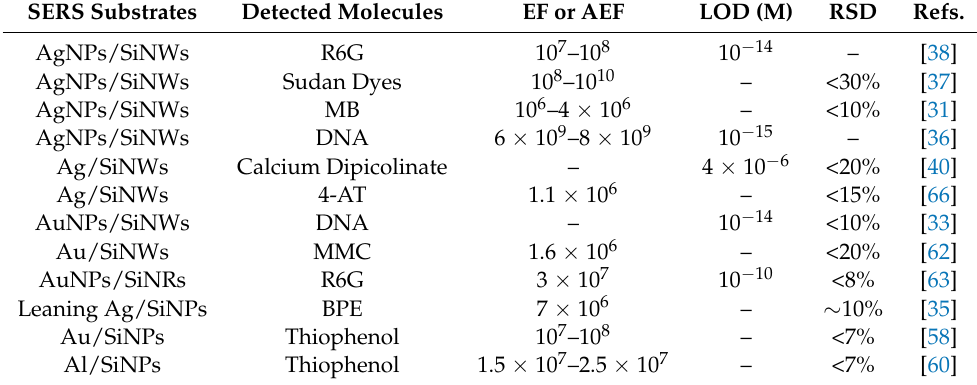
Figure 2. ( a ) Si nanowires produced by the vapor–liquid–solid growth (height: 5 µ m < h < 6 µ m and nanowire diameter: 50 nm < D < 150 nm) coated with Ag nanoparticles (diameter: 4 nm < d < 40 nm); ( b ) SERS spectrum of Rhodamine 6G (R6G) molecules (C R 6 G = 10 − 9 M) adsorbed on AgNPs/SiNWs. ( a , b ) are reprinted with permission from [38], copyright 2009 American Chemical Society; ( c ) Si nanorod array obtained with the combination of the NSL and MACE techniques followed by the grafting of gold nanoparticles having a diameter of 20 nm on Si nanorods (period P ∼ 500 nm between two Si nanorods, diameter D ∼ 200 nm and height h ∼ 1300 nm); ( d ) SERS spectra of R6G molecules adsorbed on AuNPs/SiNRs for concentrations varying from 10 − 10 to 10 − 6 M; ( c , d ) are reprinted with permission from [63], copyright 2017 American Chemical Society. Table 1. SERS performances of metal-coated Si nanosystems for chemical and biological sensing. SERS Substrates Detected